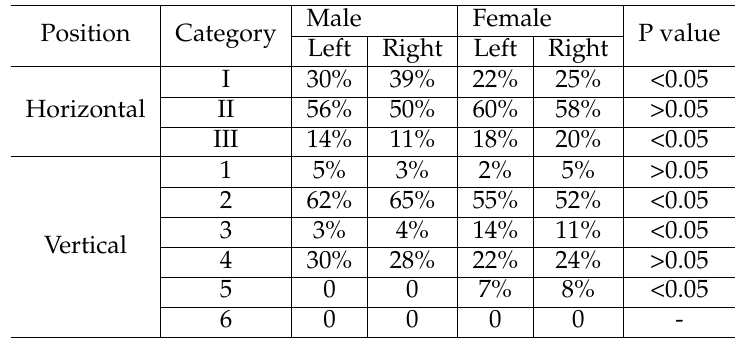
Table 2. Position of mental